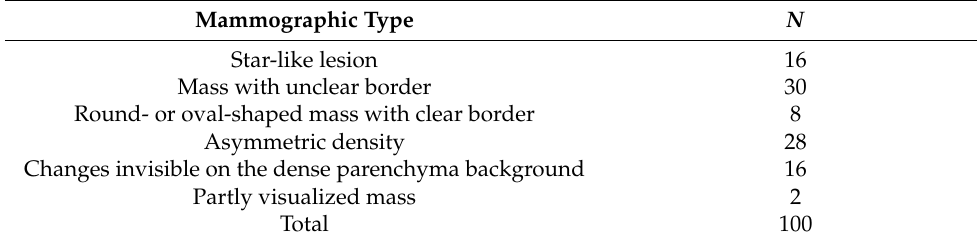
Table 1. The distribution of the mammographic BC types in the test